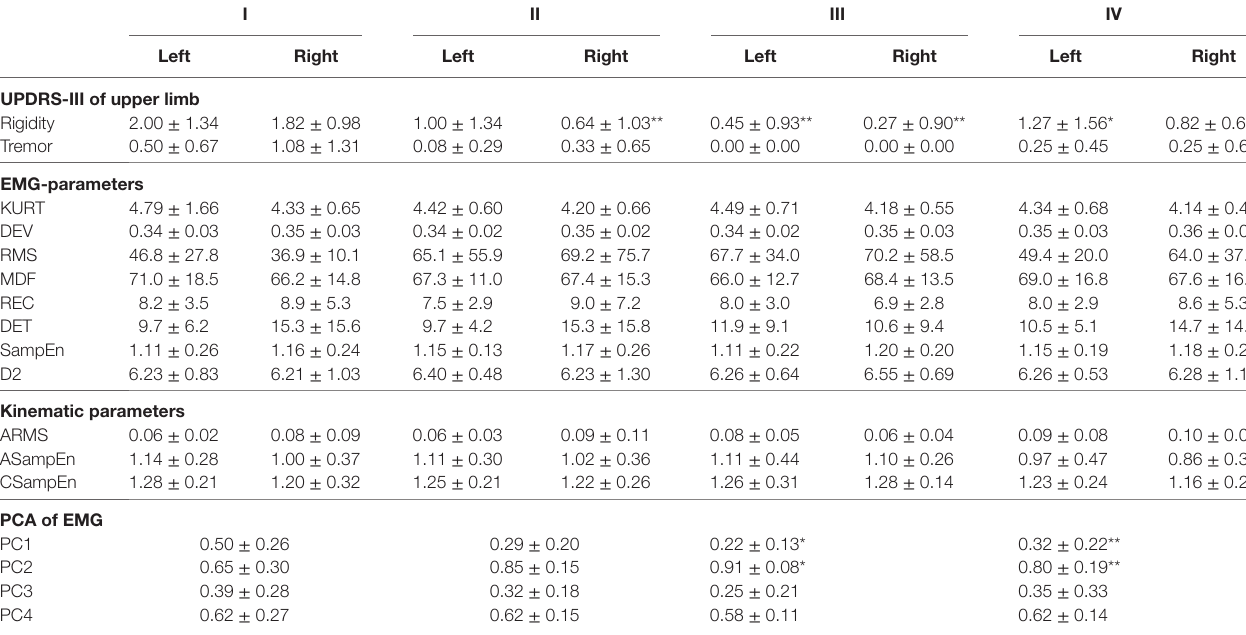
Table 3 | Parameters of isometric tension task. i ii iii iV left right left right left right left right UPDrs-iii of upper limb